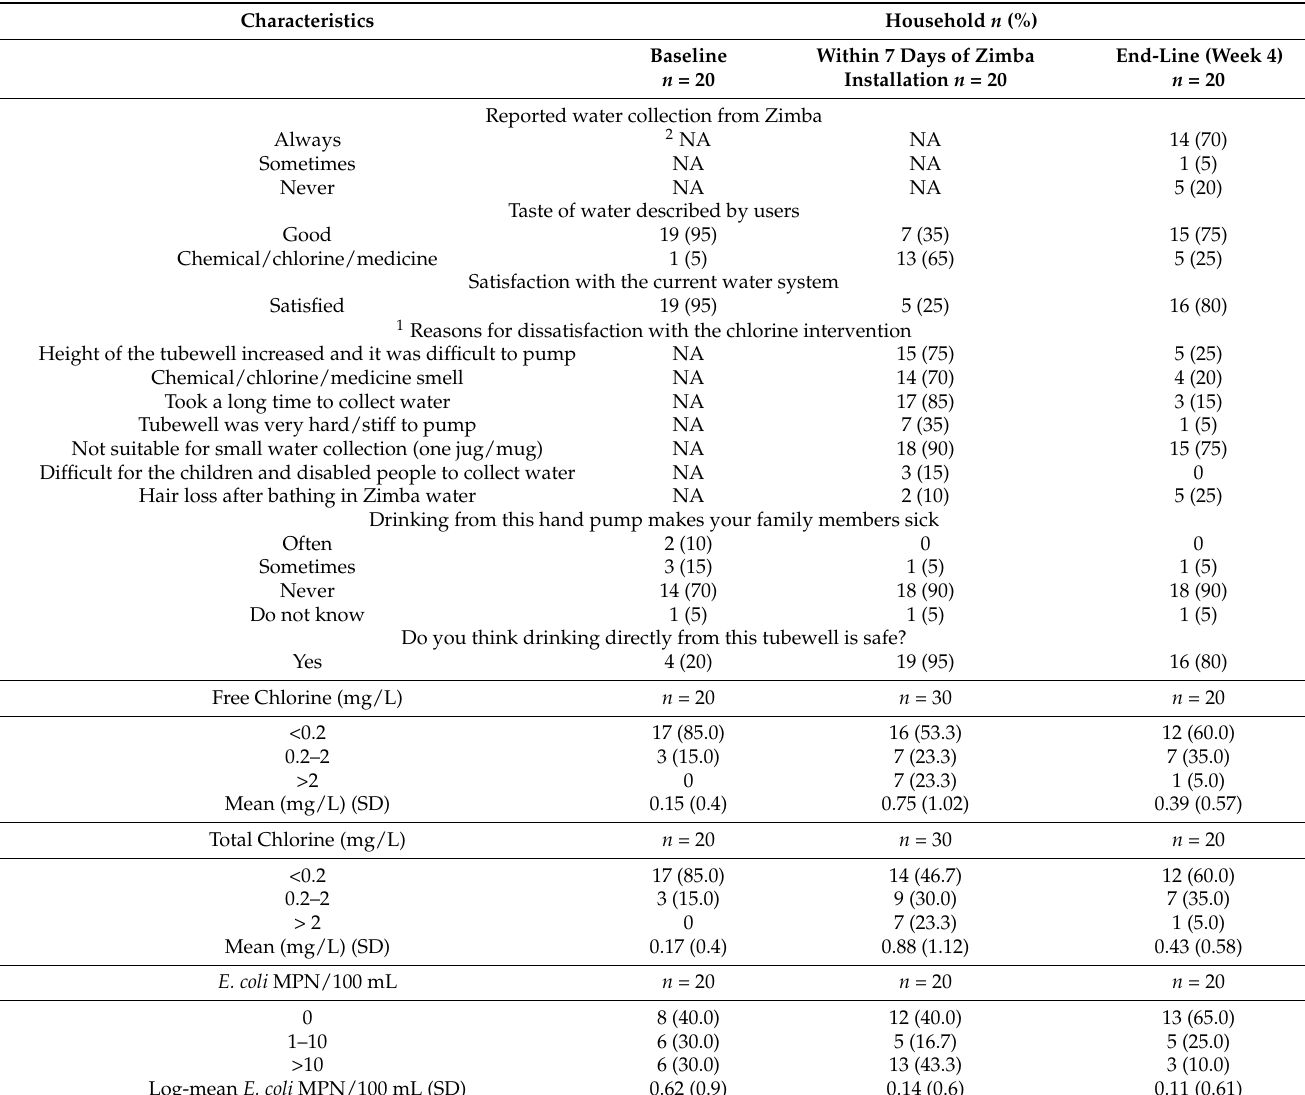
Table 3. Acceptability and satisfaction with water in households at baseline, within 7 days of Zimba installation, and at end-line in FDMN camps, Cox’s Bazaar,